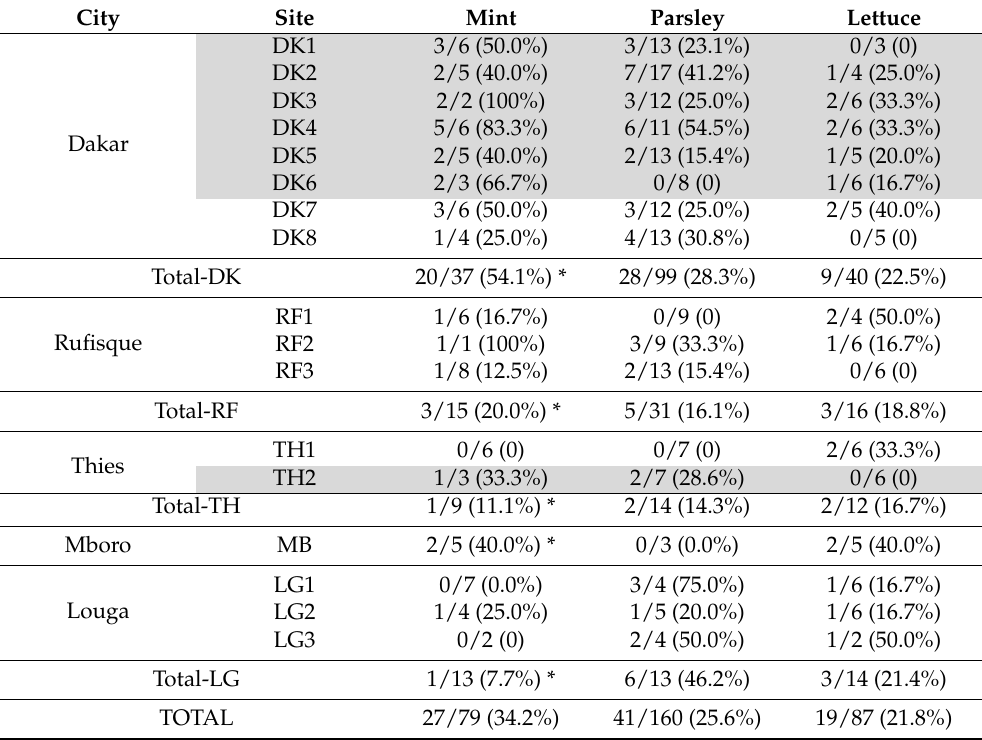
Table 2. Salmonella contamination of mint, parsley and lettuce according to cities and sampling sites. City Site Mint Parsley